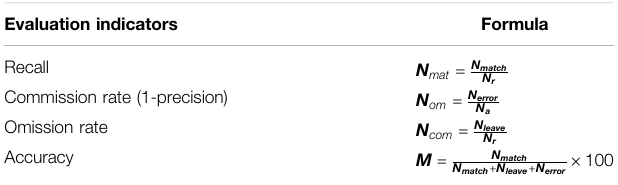
TABLE 4 | Single tree detection evaluation indicators. Evaluation